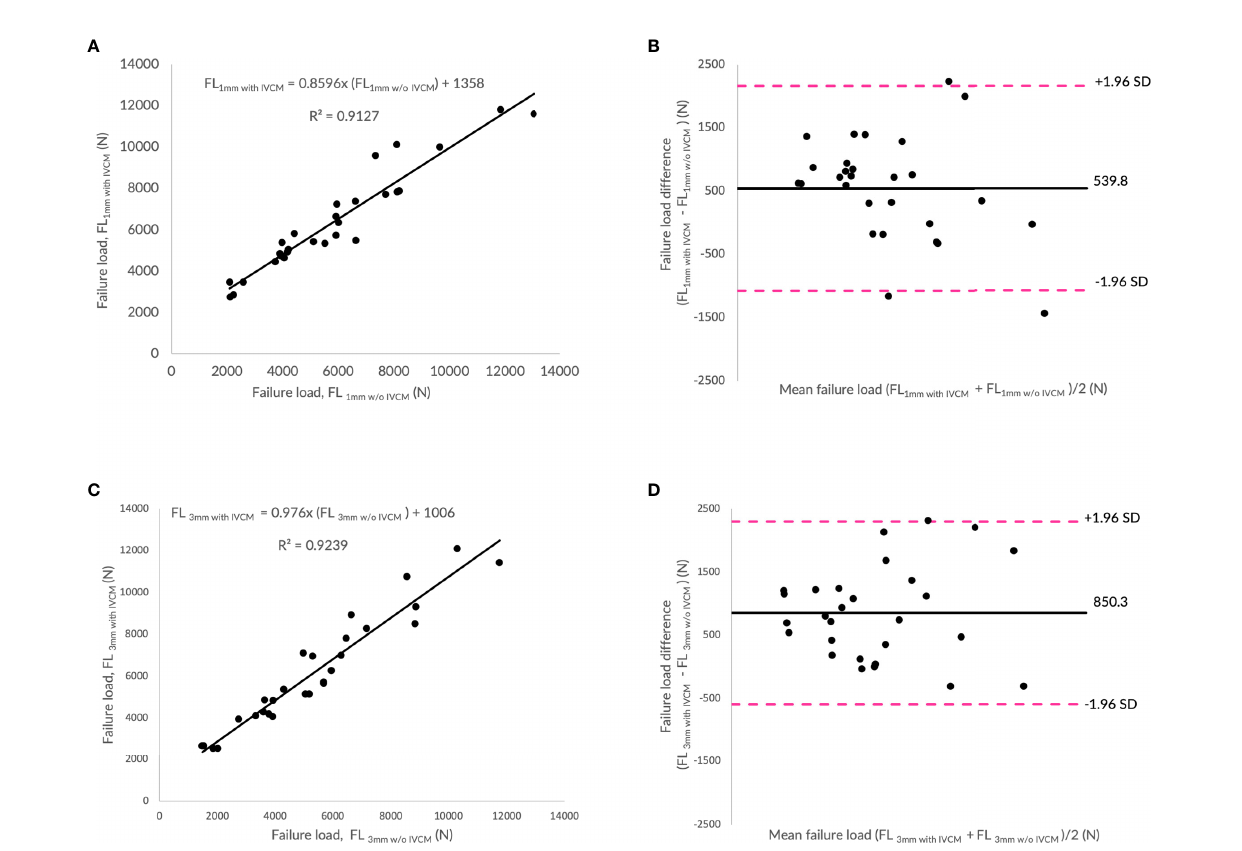
FIGURE 3 | Effect of intravenous contrast medium (IVCM) on fi nite element (FE)-predicted failure load values. (A) Correlation plot between FE-predicted failure load values for 1mm with and without IVCM, (C) correlation plot between FE-predicted failure load values for 3mm with and without IVCM, and (B, D) Bland Altman plots representing the mean of FE-predicted failure load values versus difference between them in 1 and 3mm scan settings, respectively. Horizontal lines represent mean and dashed line ±1.96 standard deviation. FL represents FE-predicted vertebral failure load